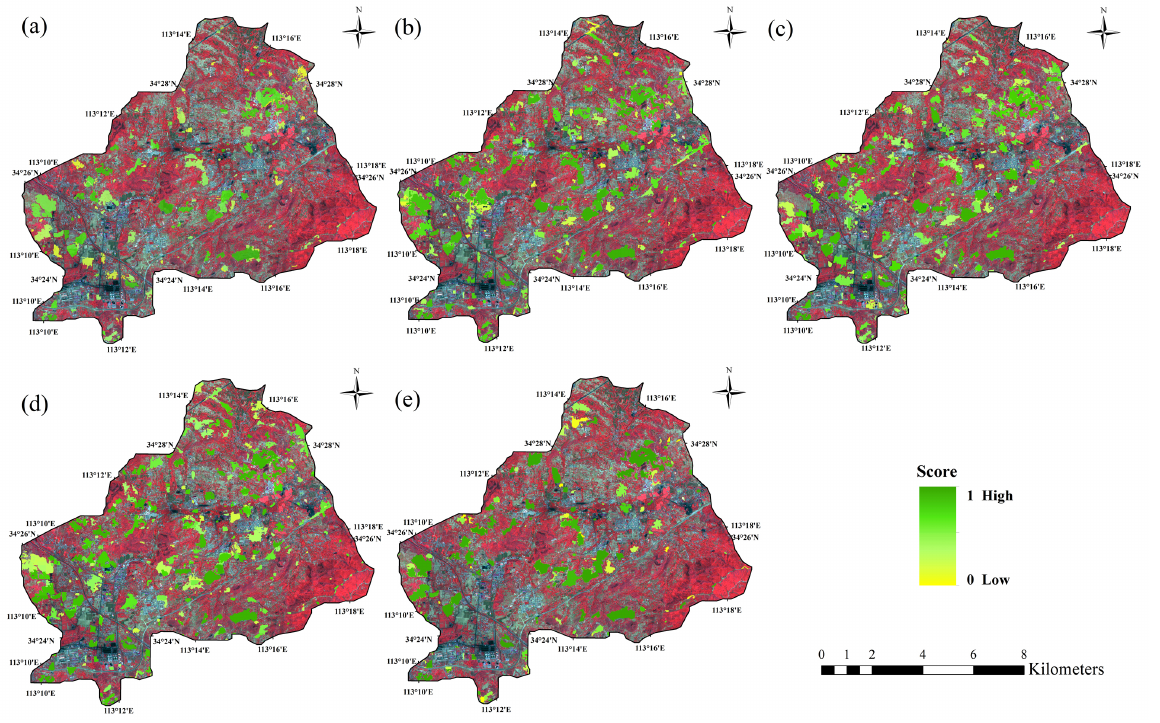
Figure 11. Detection results on Gaofen satellite false-color image in Daye Town. ( a ) Detection result by BlendMask model; ( b ) detection result by BlendMask-VoV model; ( c ) detection result by CondInst model; ( d ) detection result by CondInst-VoV model; ( e ) detection result by Mask R-CNN